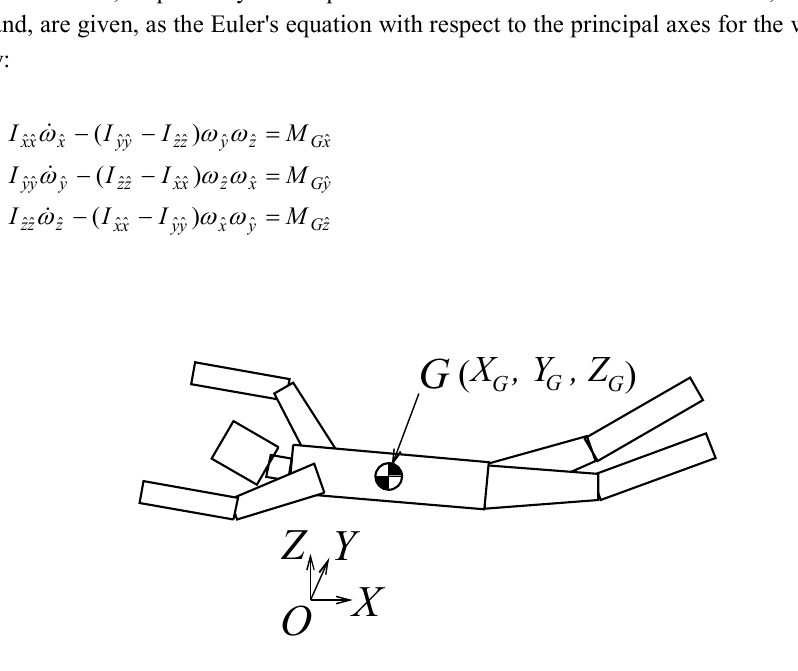
Fig. 1 Schematic view of analytical model for